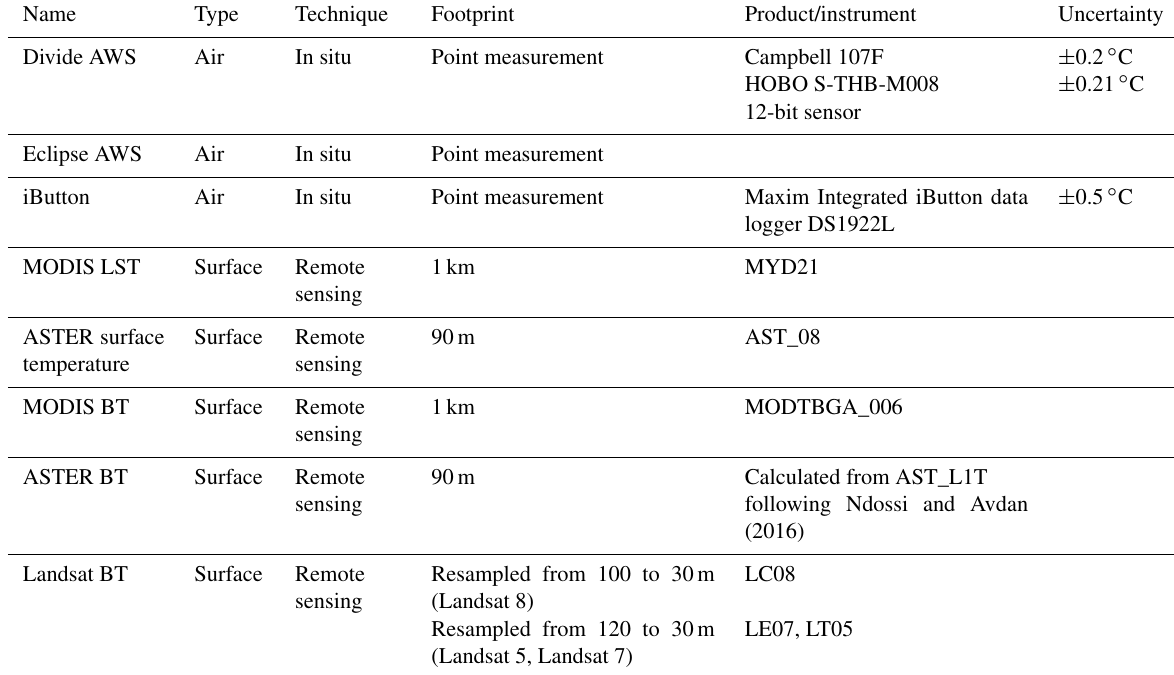
Table 1. Temperatures used in this study. Type refers to air or surface temperature. Technique refers to the instrumentation or method of measurement. Unknown values are left blank.